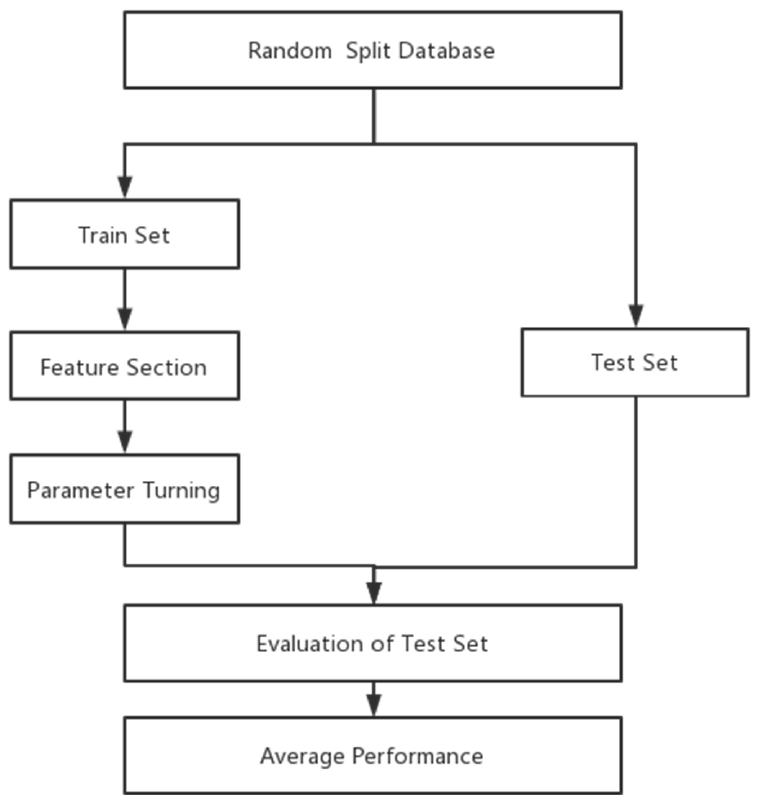
Figure 2. Training and evaluation procedures of the machine learning model.